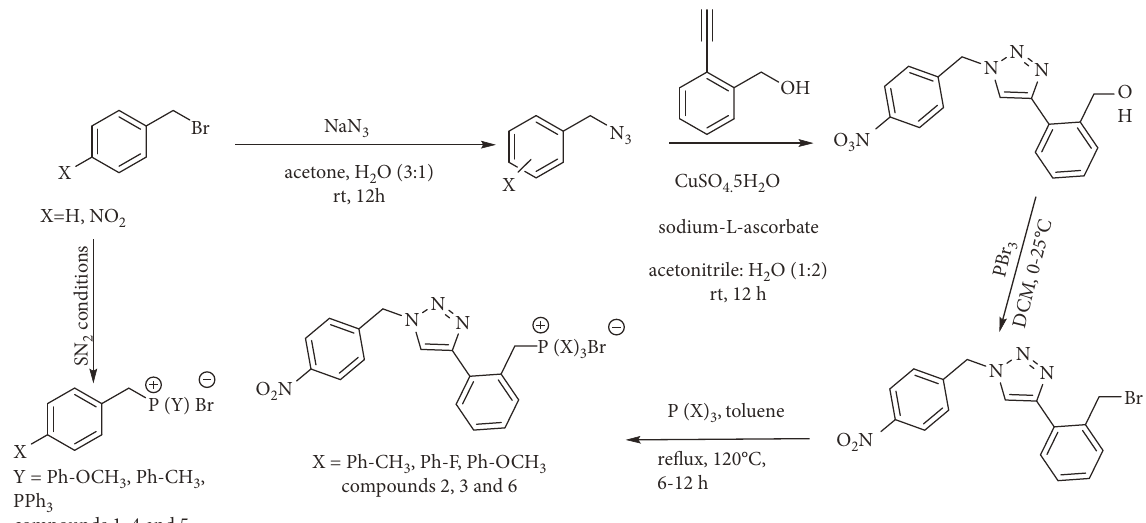
Figure 1: Synthesis of the phosphonium salts and a tethered/hybrid phosphonium salt (1, 4, 5 for Ph-OCH TOLYL), and PPh3, respectively) and 2, 3, 6 for Ph-CH 3 (2ET-TOL), Ph-F (2-ET-FLU), and Ph-OCH 3 (PZ). SN 2 conditions: PY 3 (tri- phenylphosphine derivative) in toluene, reflux at 120 °